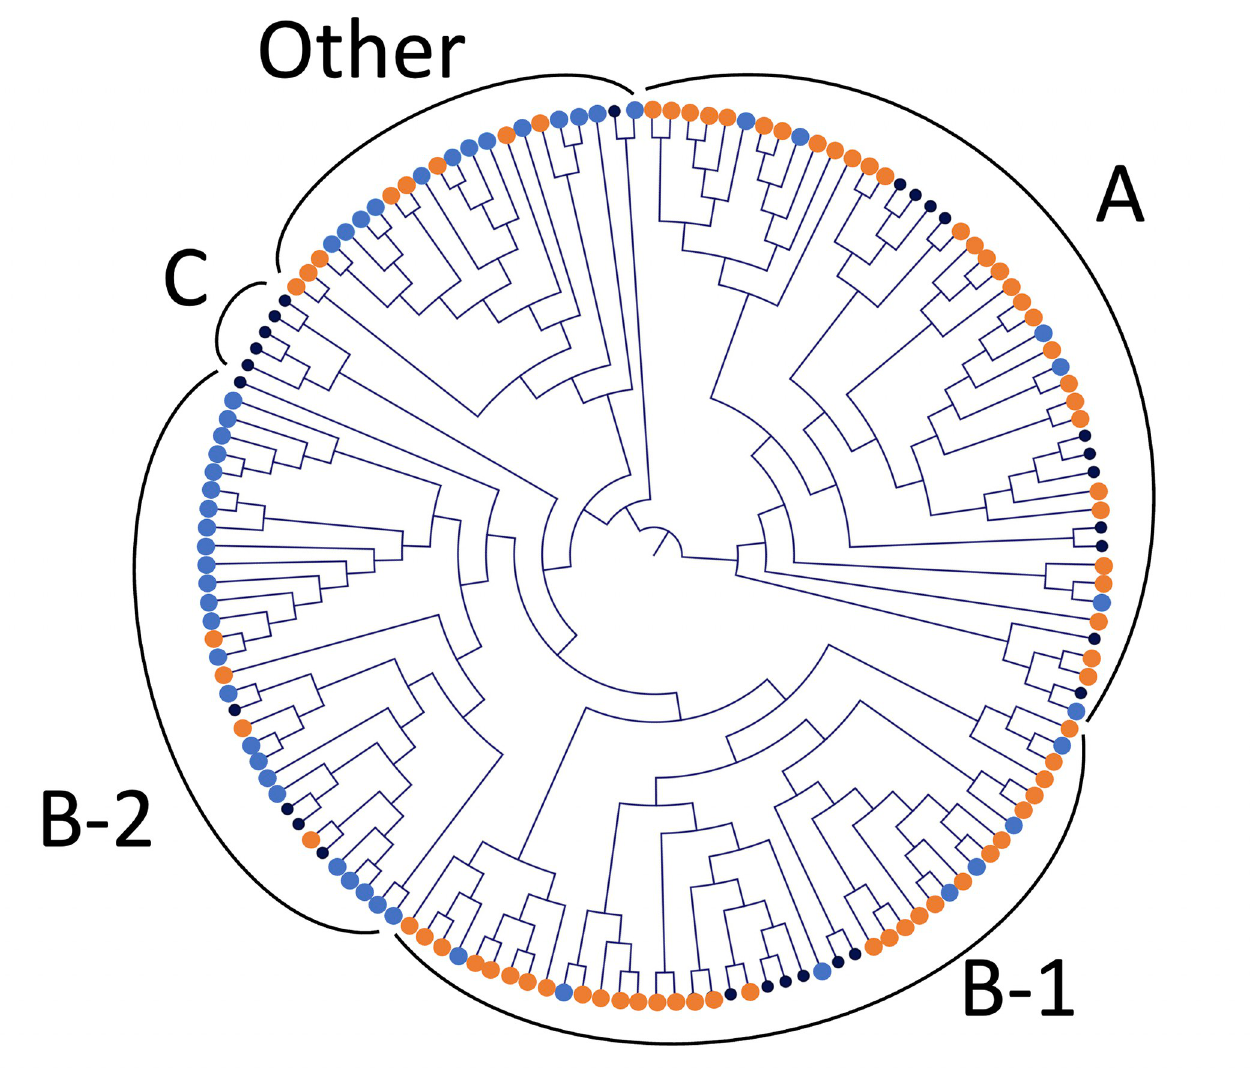
Fig 2. Phylogenetic analysis of the whole BLV genome sequences. A maximum-likelihood phylogenetic tree was constructed from whole BLV genome sequences of 72 EBL cattle under 3 years old, 50 EBL cattle over 3 years old and 28 reference sequences. The BLV were divided into 5 groups (A, B-1, B-2, C and Other). BLV from EBL cattle under 3 years old, EBL cattle over 3 years old and references were shown by red, blue and black circles,